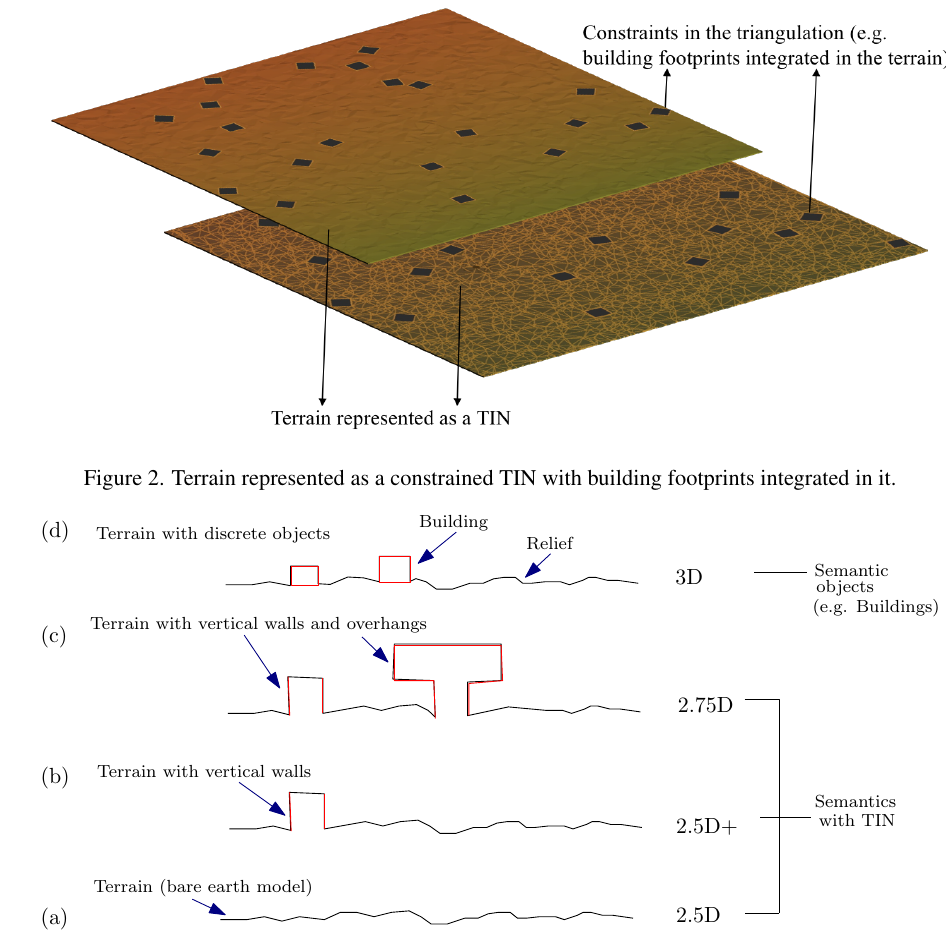
Figure 3. Terrain as a TIN modelled to represent features like vertical walls, roof overhangs, etc. (Source: Kumar et al. (2018)) angulation, etc. A terrain is modelled as a ReliefFeature which consists of one or more entities of the class ReliefComponent , which can be a TIN or a grid and so on. Both ReliefFeature and ReliefComponent(s) have an dem:lod attribute for the level of detail (OGC, 2012). The LOD of a ReliefFeature can differ from the LOD of its ReliefComponents (OGC,